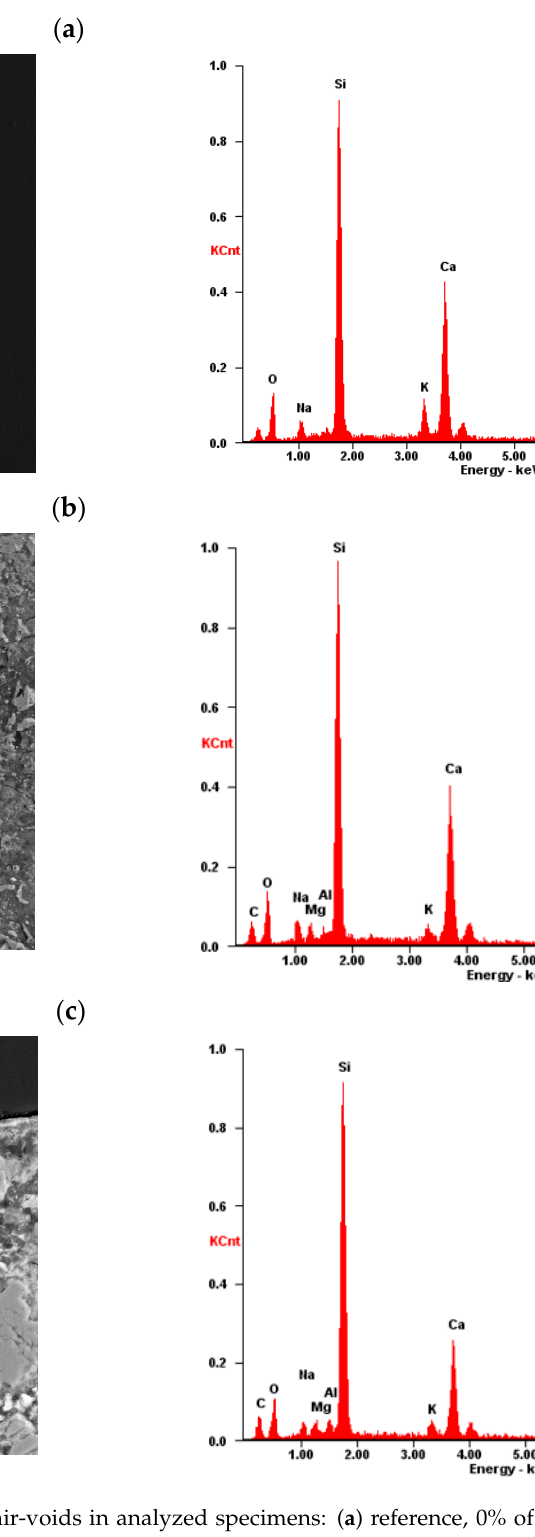
Figure 9. ASR-gel formed in air-voids in analyzed specimens: ( a ) reference, 0% of calcined clay, ( b ) 10% of clay calcined at 850 °C, ( c ) 20% of clay calcined at 850 °C; a star represents the location of the EDS analysis.